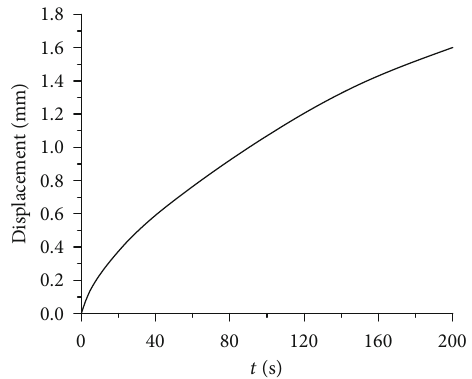
Figure 15: Evolution of nose cap tip deformation with